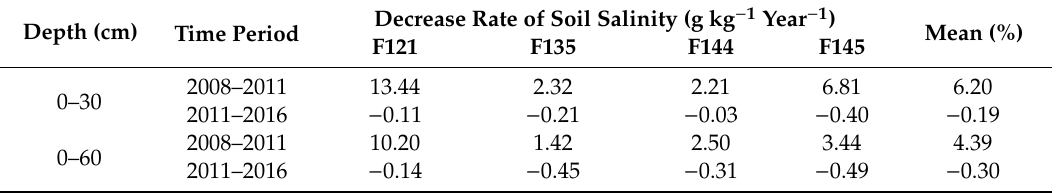
Table 1. Decrease rate of soil salinity in di ff erent soil layers in the salt wastelands, 2008–2016. Depth